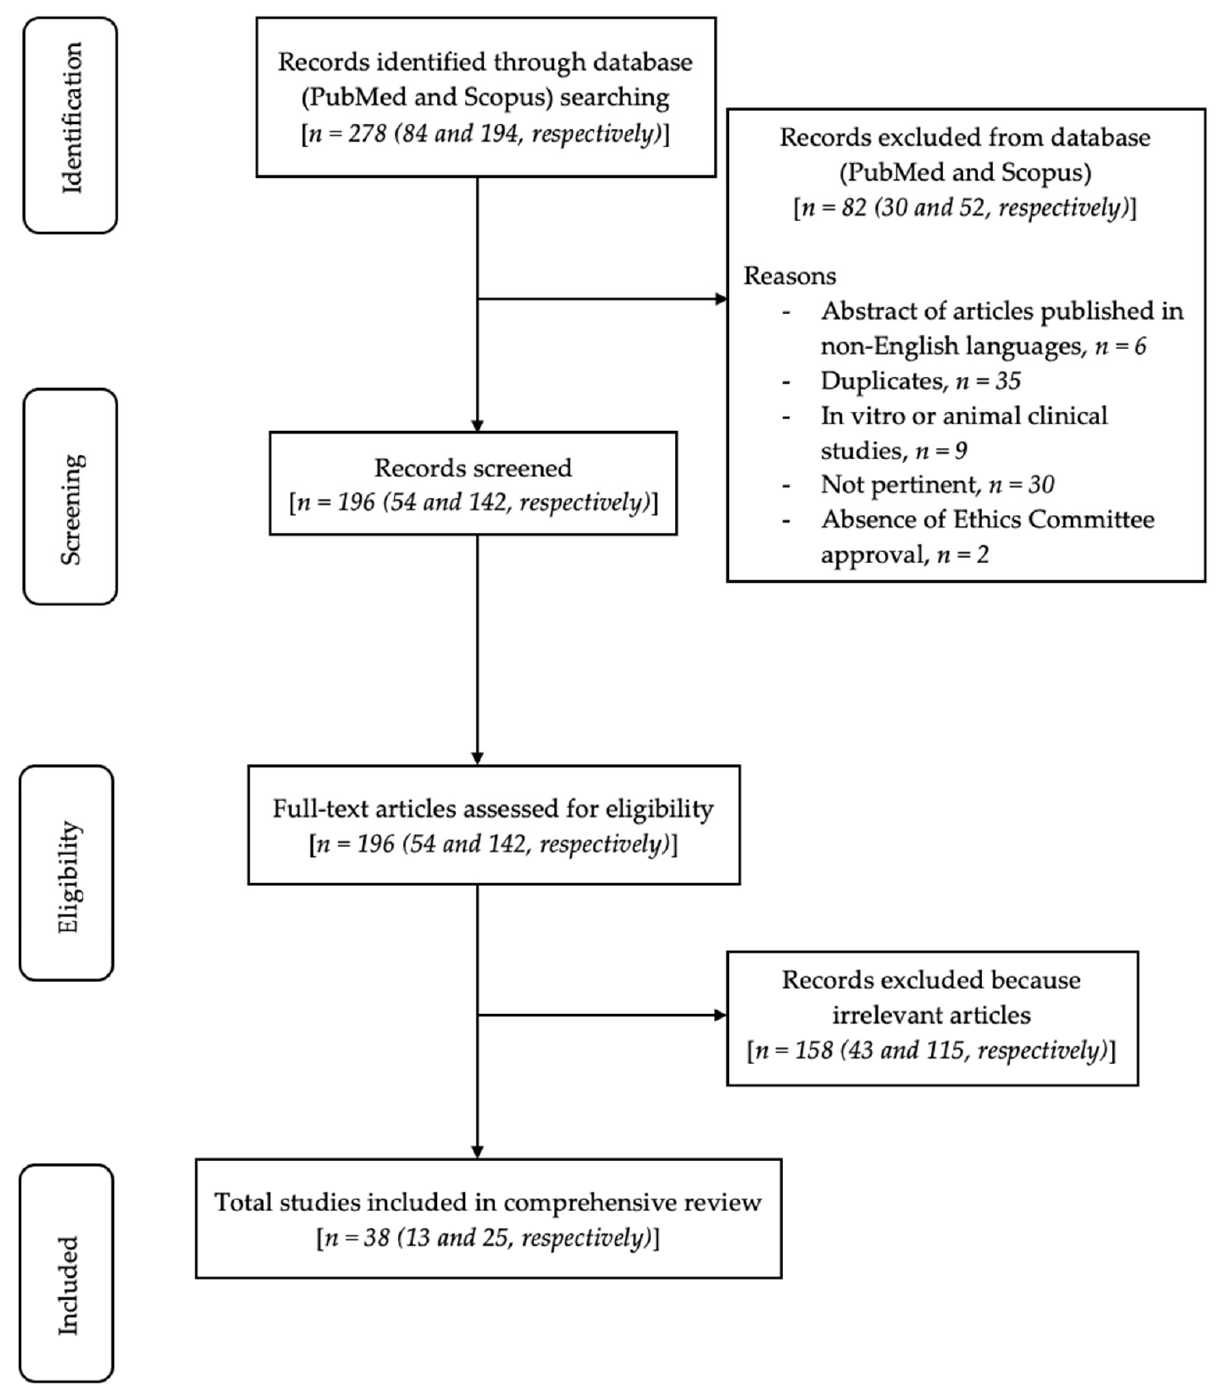
Figure 1. Flow chart of the review process.